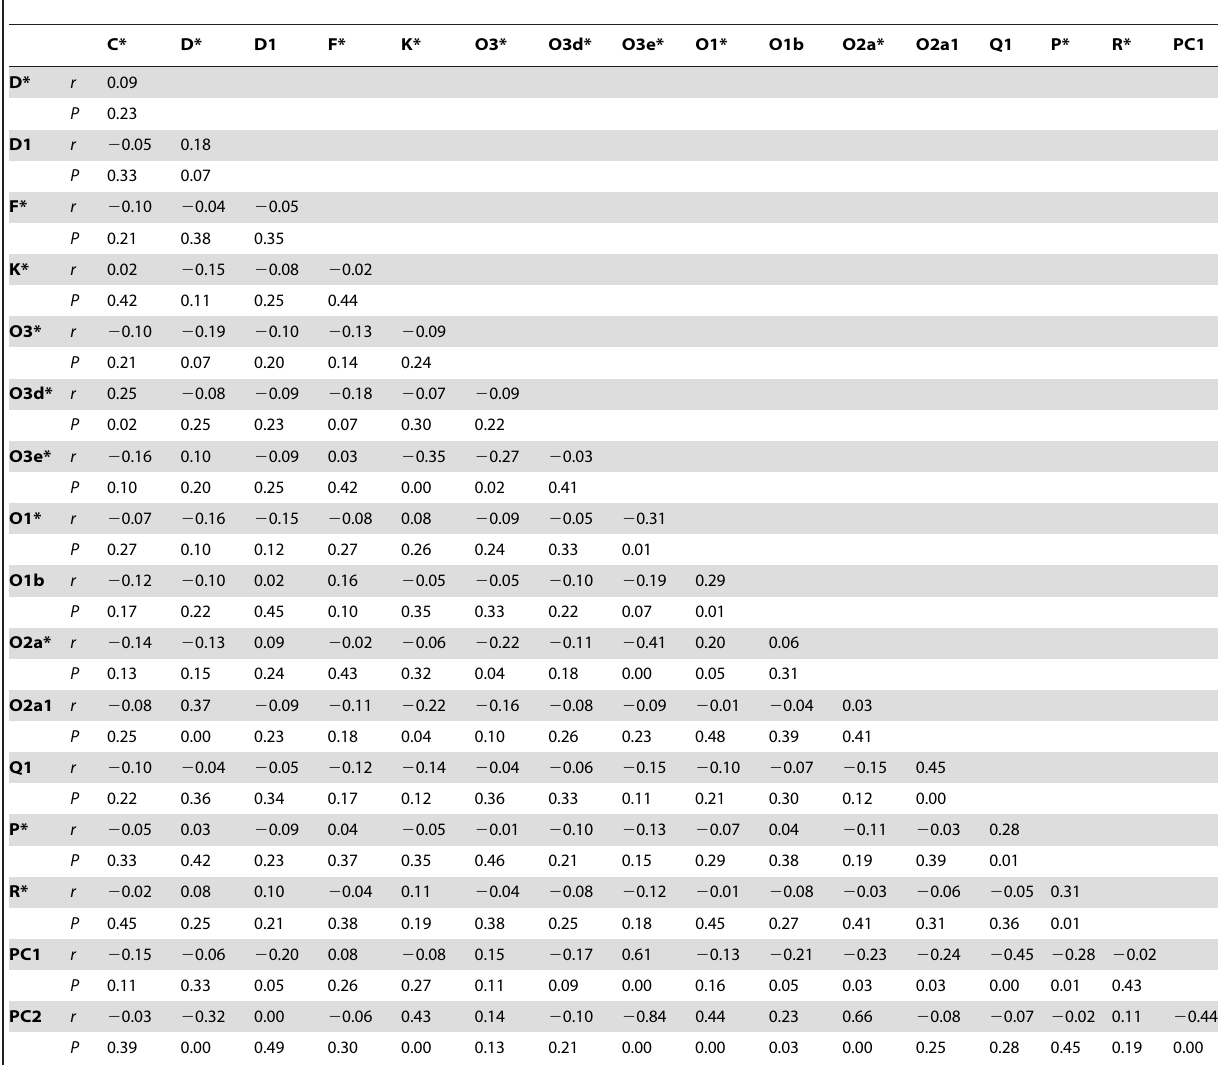
Table 4. Correlation analysis of principal components and Y-SNP frequencies among